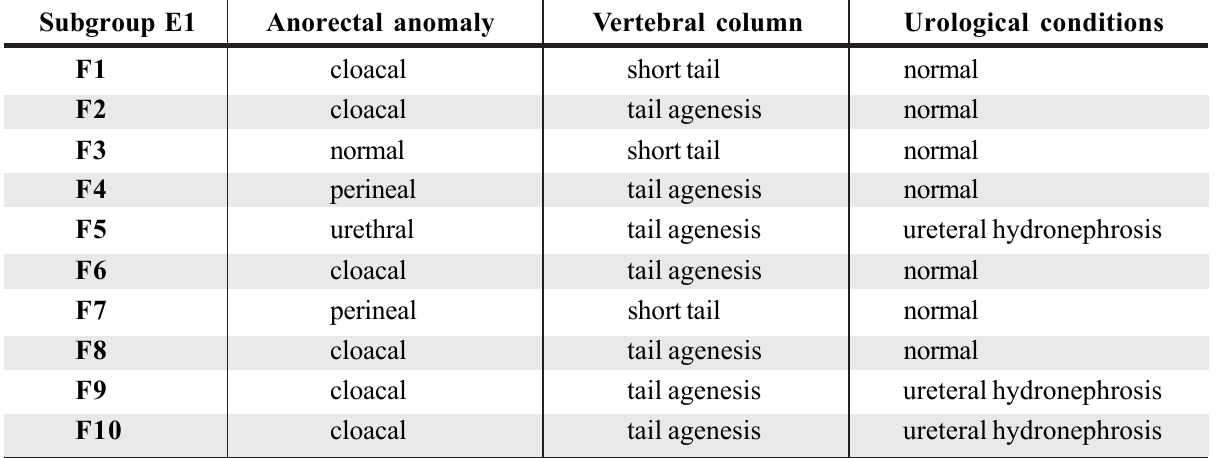
TABLE 5 - Associations between anomalies for the fetuses in subgroup